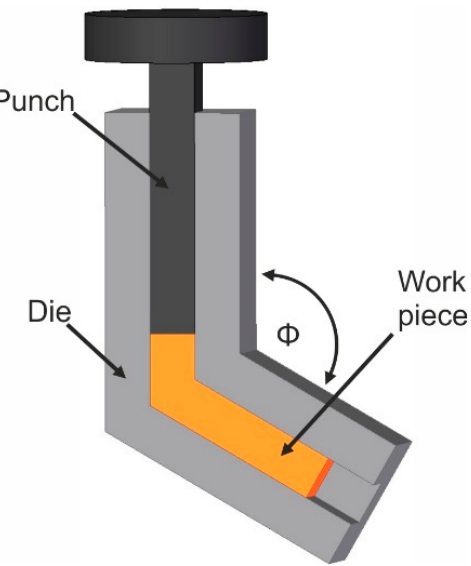
Figure 1. Principle sketch of the ECAP-process (Equal Channel Angular Pressing).